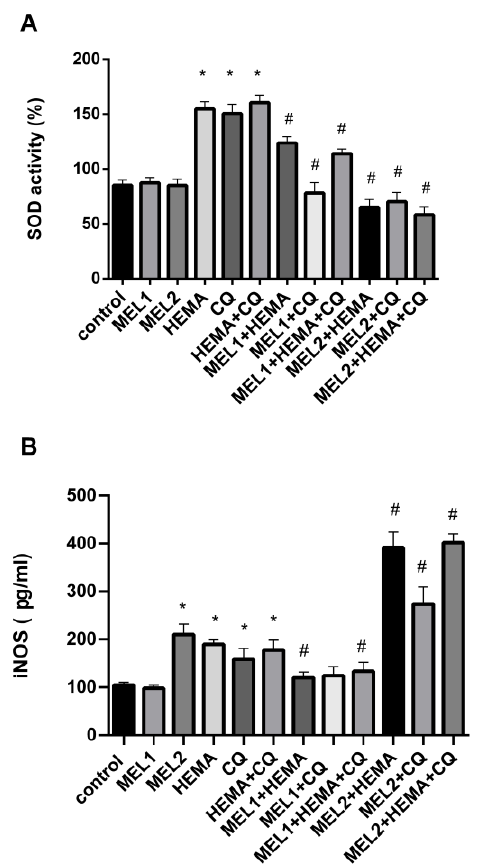
Figure 5. HEMA- and/or CQ-induced effects on SOD activity ( A ) and iNOS protein expression levels ( B ) in human dental pulp cells in the presence of melatonin (24 h). Each graph bar represents the mean ± SD of four experiments. * p < 0.05 chemical vs. control; # p < 0.05 chemical with melatonin vs. without melatonin. SOD—superoxide dismutase; iNOS—inducible nitric oxide synthase; MEL1 (0.1 mM) and MEL2 (1 mM)—melatonin; HEMA—2-hydroxyethyl methacrylate (5 mM); and CQ—camphorquinone (1 mM).